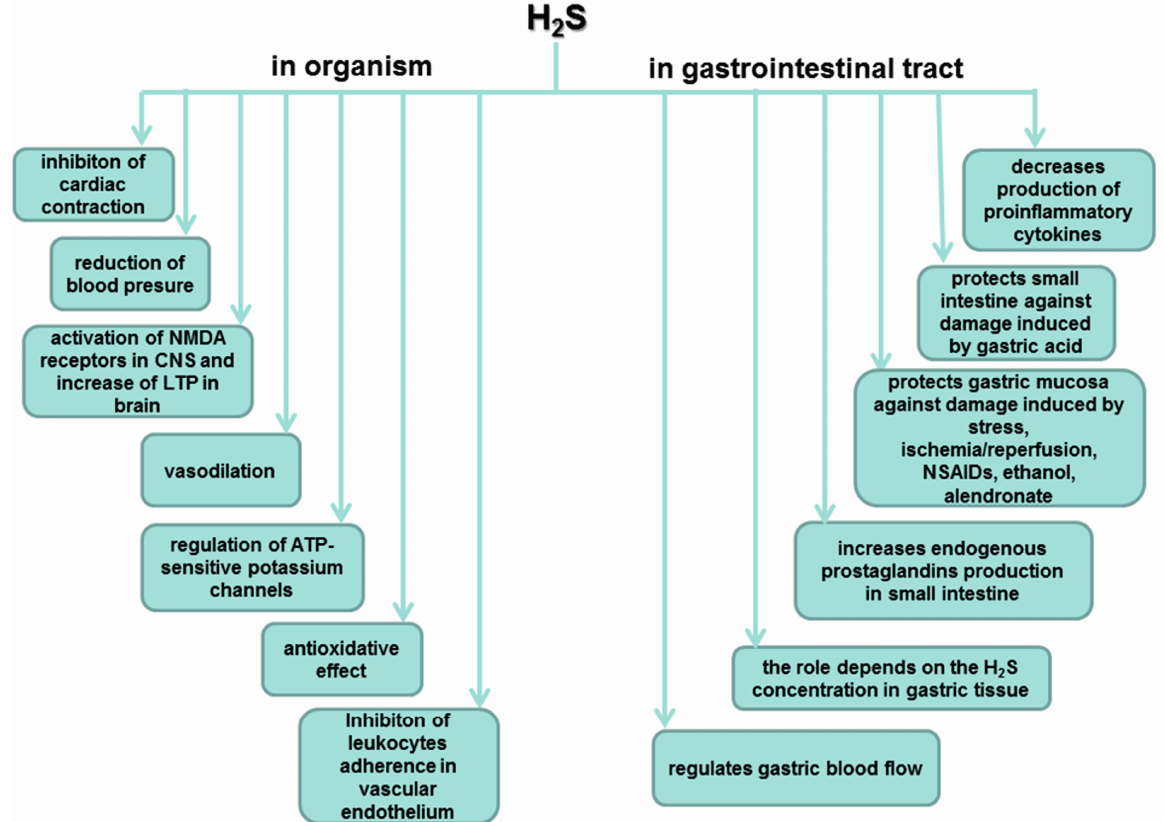
Figure 5. Role of hydrogen sulfide in organism and in gastrointestinal tract.